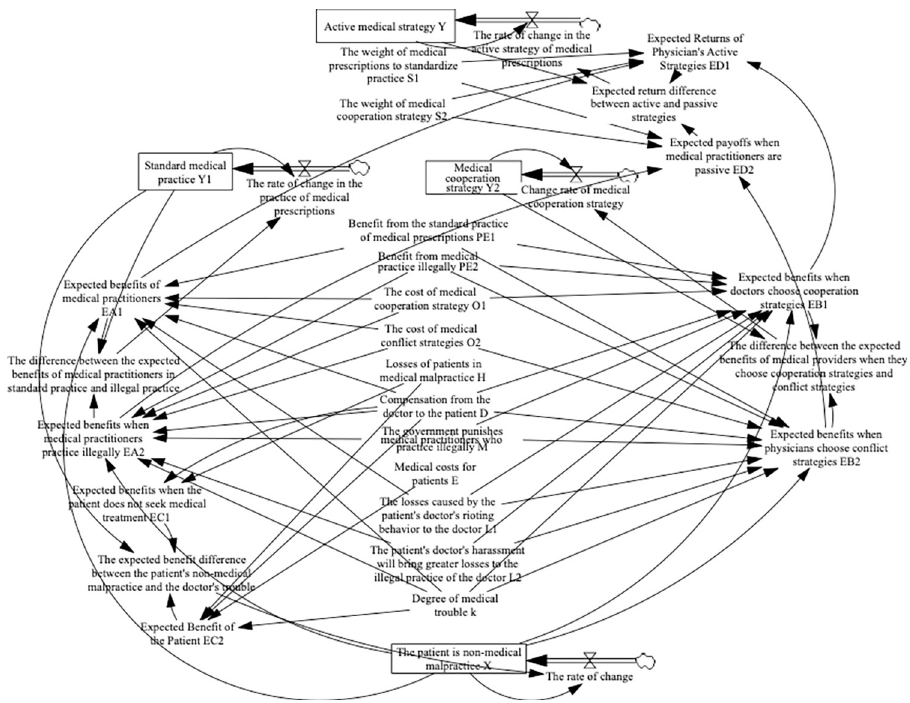
Fig 1. Evolutionary game theory model of doctors and patients in medical malpractice.